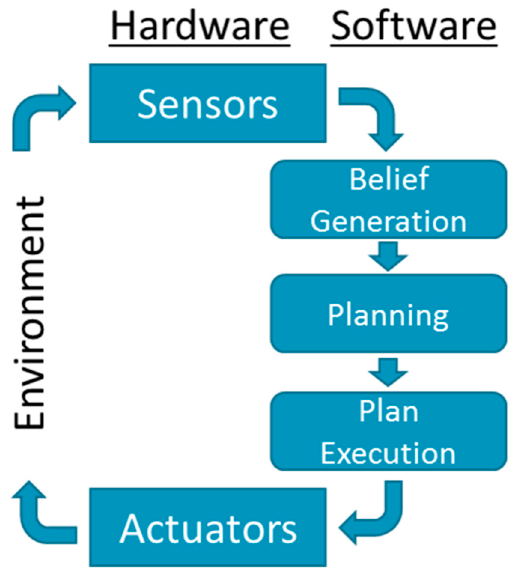
Figure 1. A general control flow of a single robot.